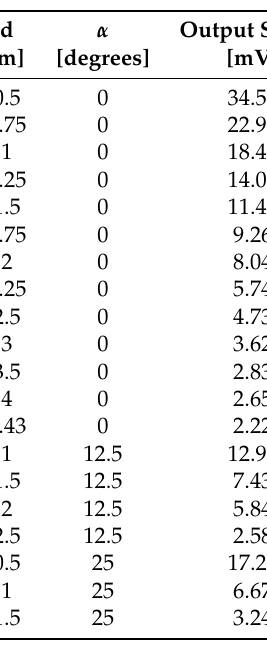
Table A1. Measurements Results for Different Person